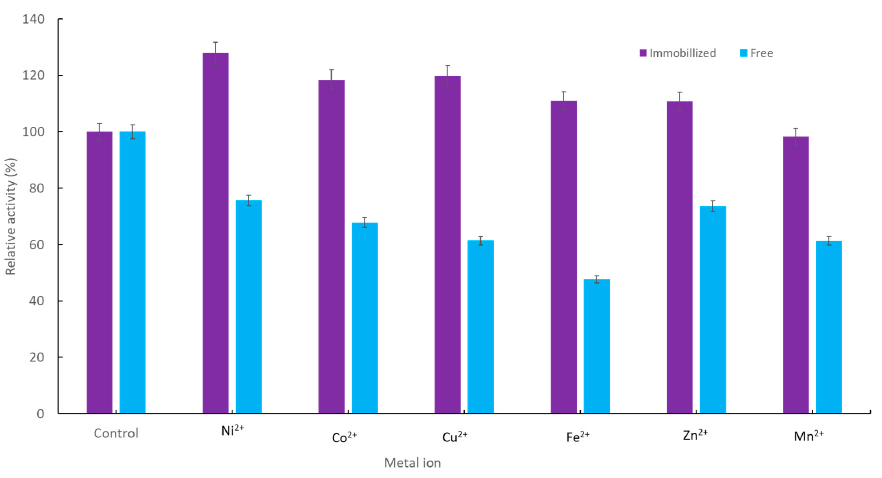
Figure 7. Effect of metal ions on activity of immobilized and free YT PTE. Purple columns: Relative activity of immobilized YT PTE; Blue columns: Relative activity of free enzyme.